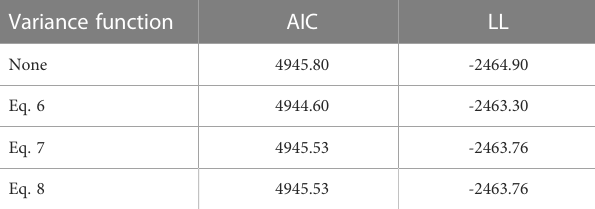
TABLE 4 AIC and LL of different variance functions applied to NLME HCB model (AIC, Akaike Information Criteria; LL, loglikelihood). Variance function